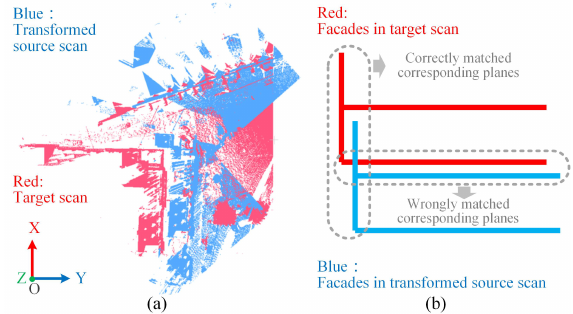
Figure 9. Illustration of ambiguities when identifying the translate parameters. (a) The translation error. (b) A sketch of the cause of